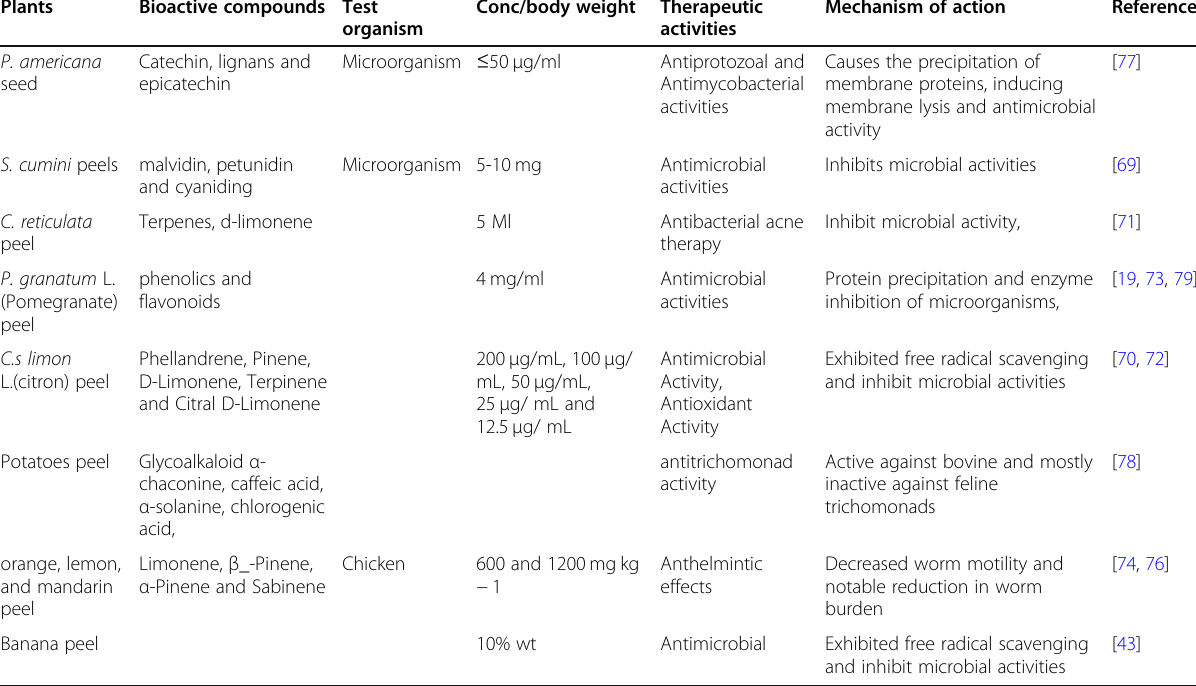
Table 4 Antimicrobial/antiparasitic properties of some peels and seed extracts